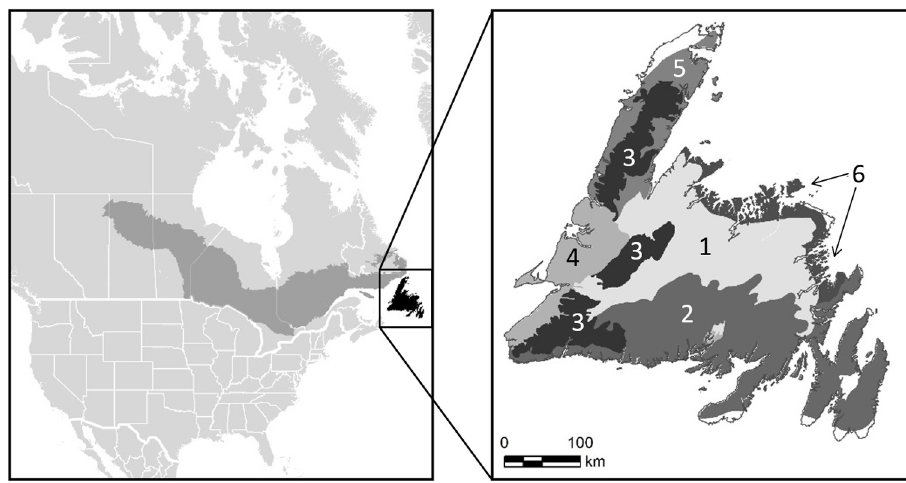
Fig 1. Study region map. Extent of the Boreal Shield ecozone in Canada and the locations of ecoregions 1 to 6 in our case study region.